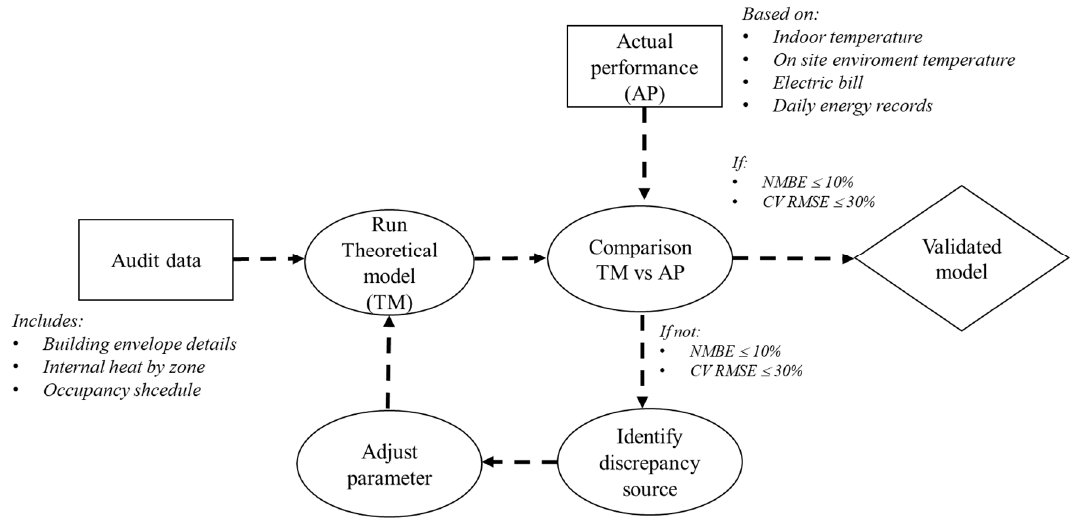
Table 2. Design properties of each case of